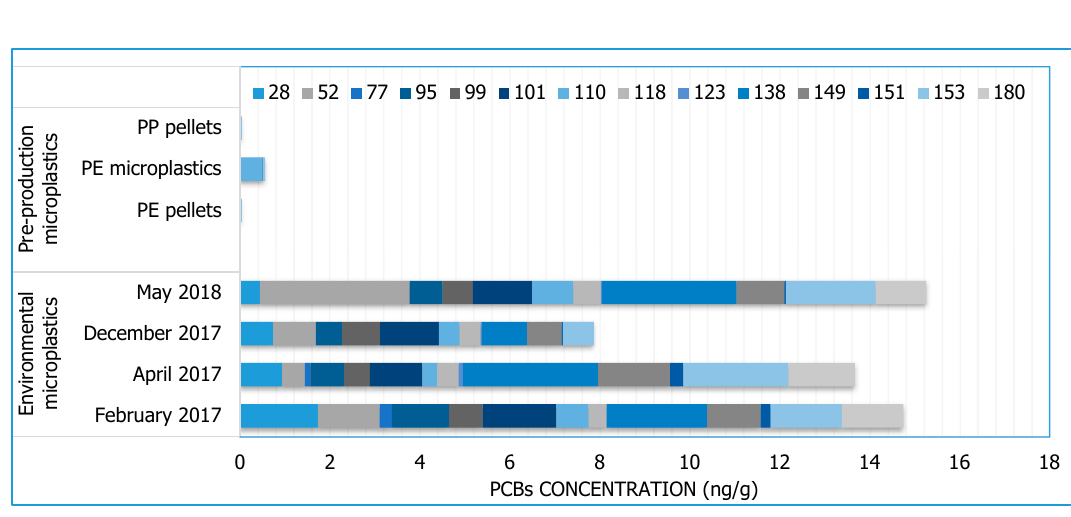
Figure 1. Concentrations of 14 polychlorobiphenyl (PCB) congeners, expressed as ng/g, registered on environmental MPs (April 2017, February 2017, December 2017, May 2018) and on virgin microplastics (MPs) (virgin polyethene (PE), virgin coloured PE, virgin polypropylene (PP)). Virgin PE and PP were colourless pellets while virgin coloured PE was green microparticles (<500 μ m).